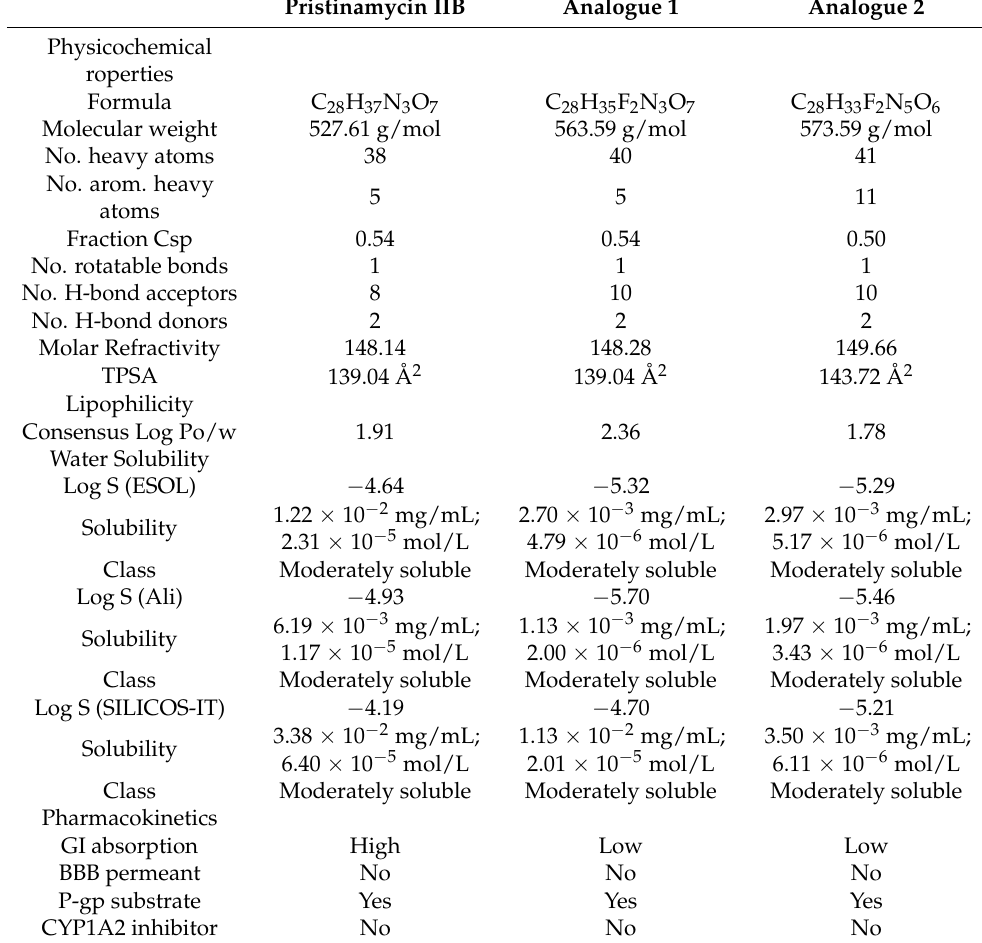
Table 1. SwissADME Table 1. SwissADME data.